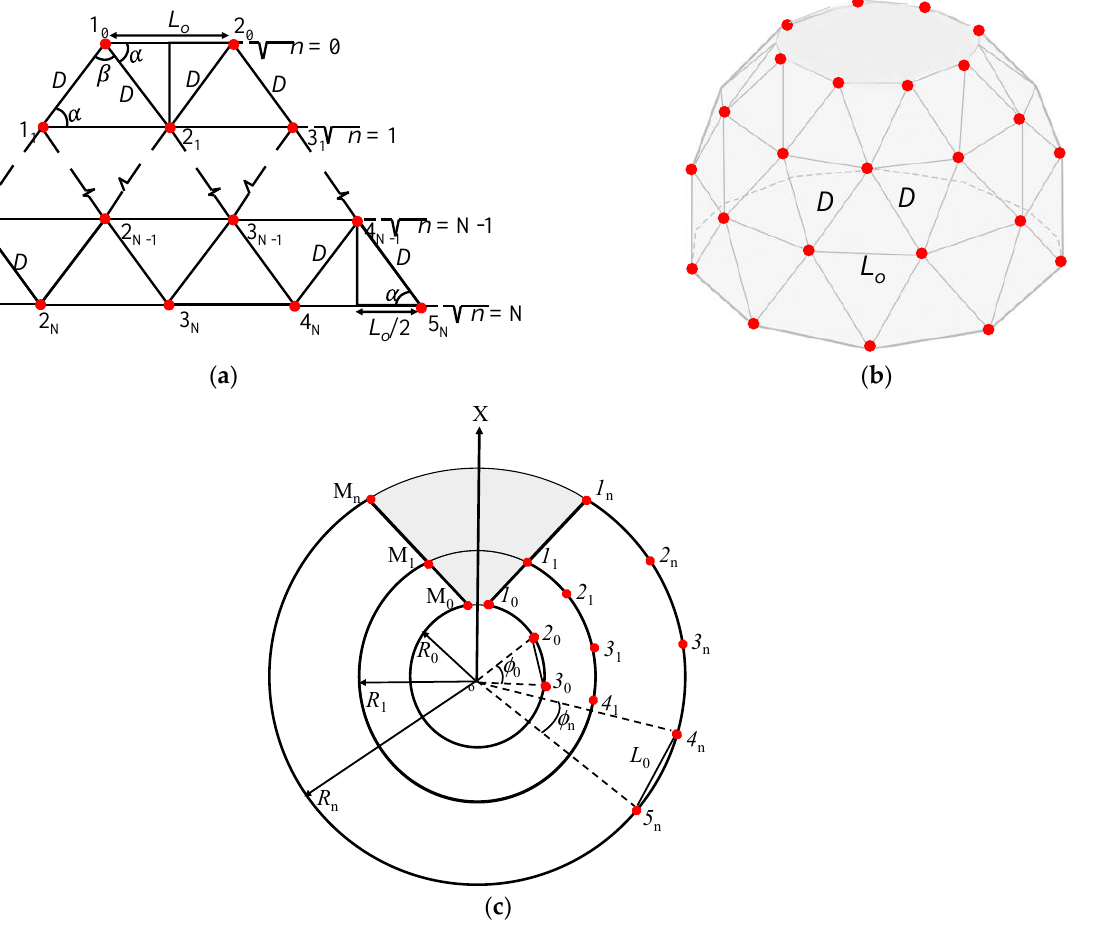
Figure 3 . Schematic representation of the GFA: ( a ) rectangular planar; ( b ) typical quasi − spherical; and ( c ) horizontal view.